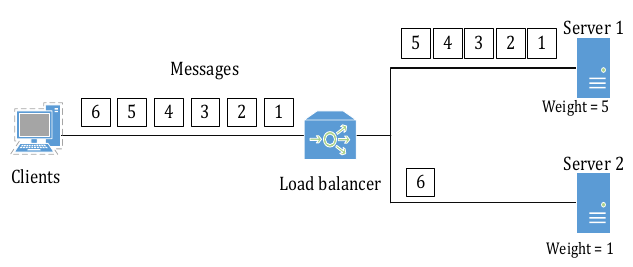
Figure 6. WRR Technique (redrawn from